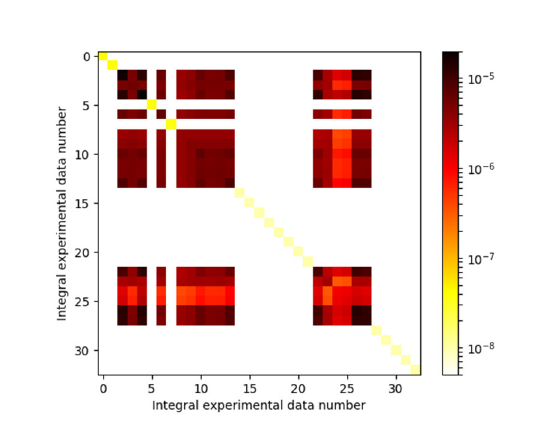
Fig. 6. Covariance structure of 𝐕 𝐦